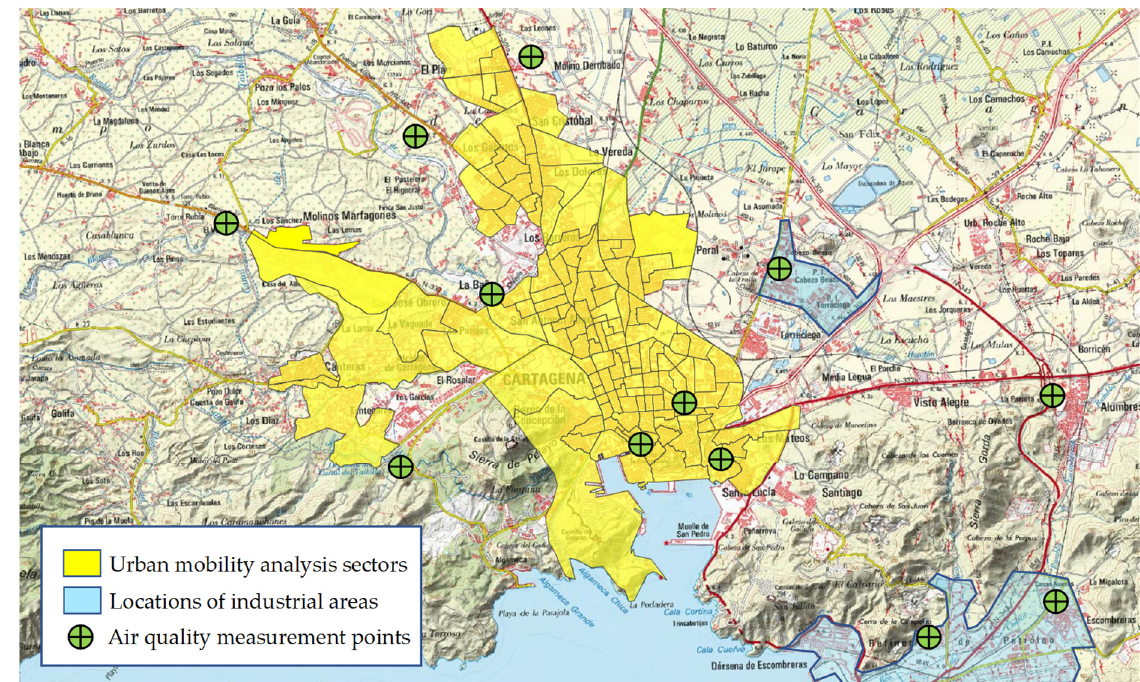
Figure 4. Compartmentalization of the city of Cartagena into sectors according to the criteria described in the text.